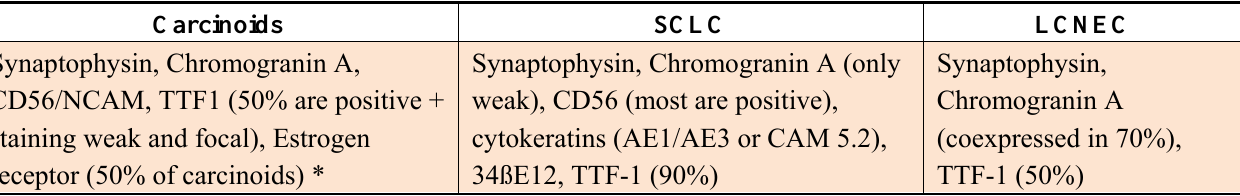
Table 2. Common immunohistochemical